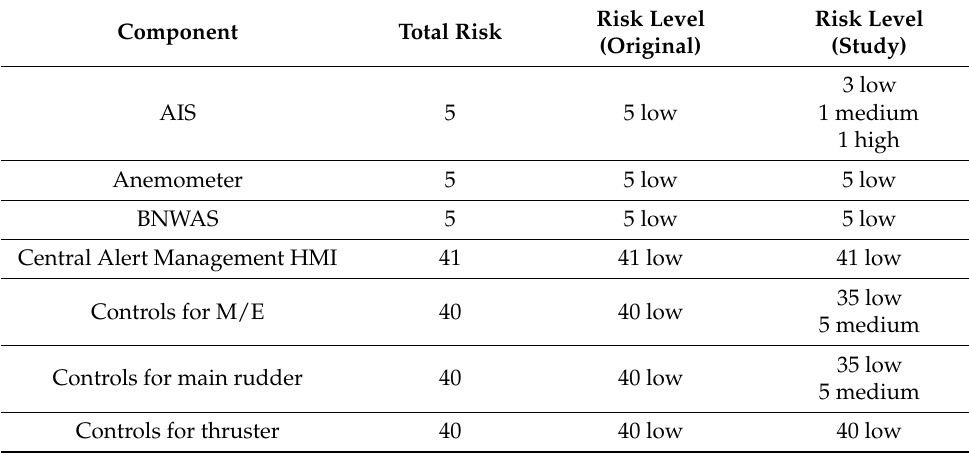
Table 12. Results of risk